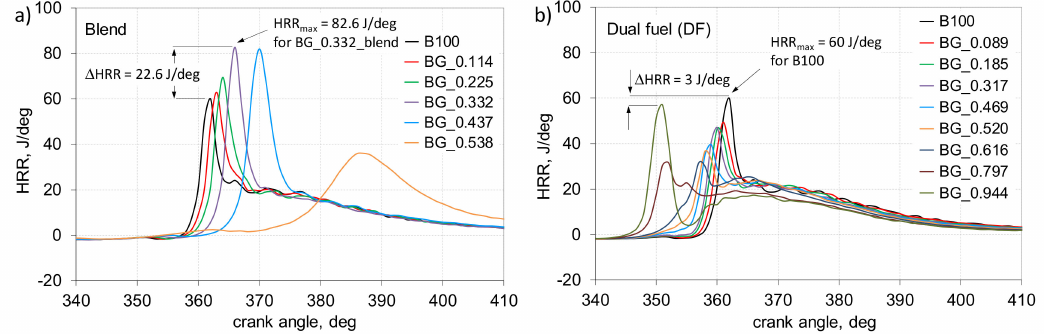
Figure 6. Heat release rate for blends ( a ) and dual fuel ( b ) combustion